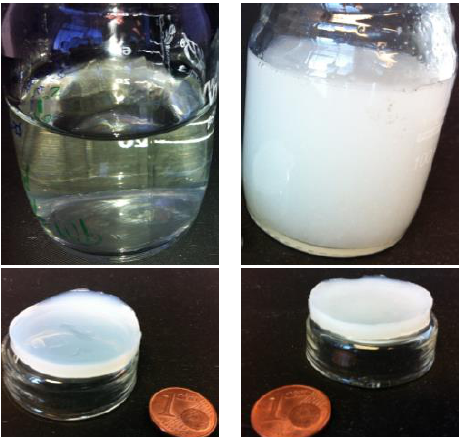
Figure 4. Reference solution ( Top-left ) and hydrogel ( Bottom-left ) of chitosan 2% ( w / w ). Solution of CHI 2% ( w / w ) filled with cellulose nanofibers 0.4% ( w / w ) (CNF/CHI suspension, Top-right ) and resulting CNF/CHI composite hydrogel ( Bottom-right ). All samples were obtained by the aqueous route.